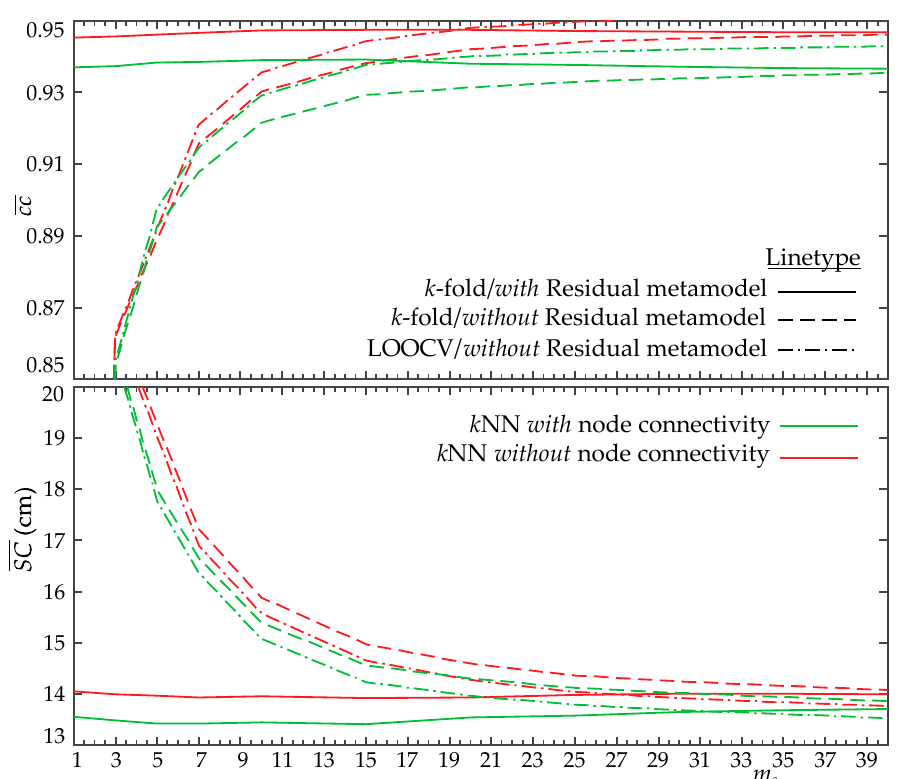
Figure 10. Averaged correlation coefficient CC (top row) and surge score SC (bottom row) validation metrics for the S s surrogate model utilizing the pseudo-surge database for different number of components ( m s ) . Different metamodel variants (use of additional metamodel on the residuals), the use of the node grid connectivity or not, and two different validation approaches are shown.